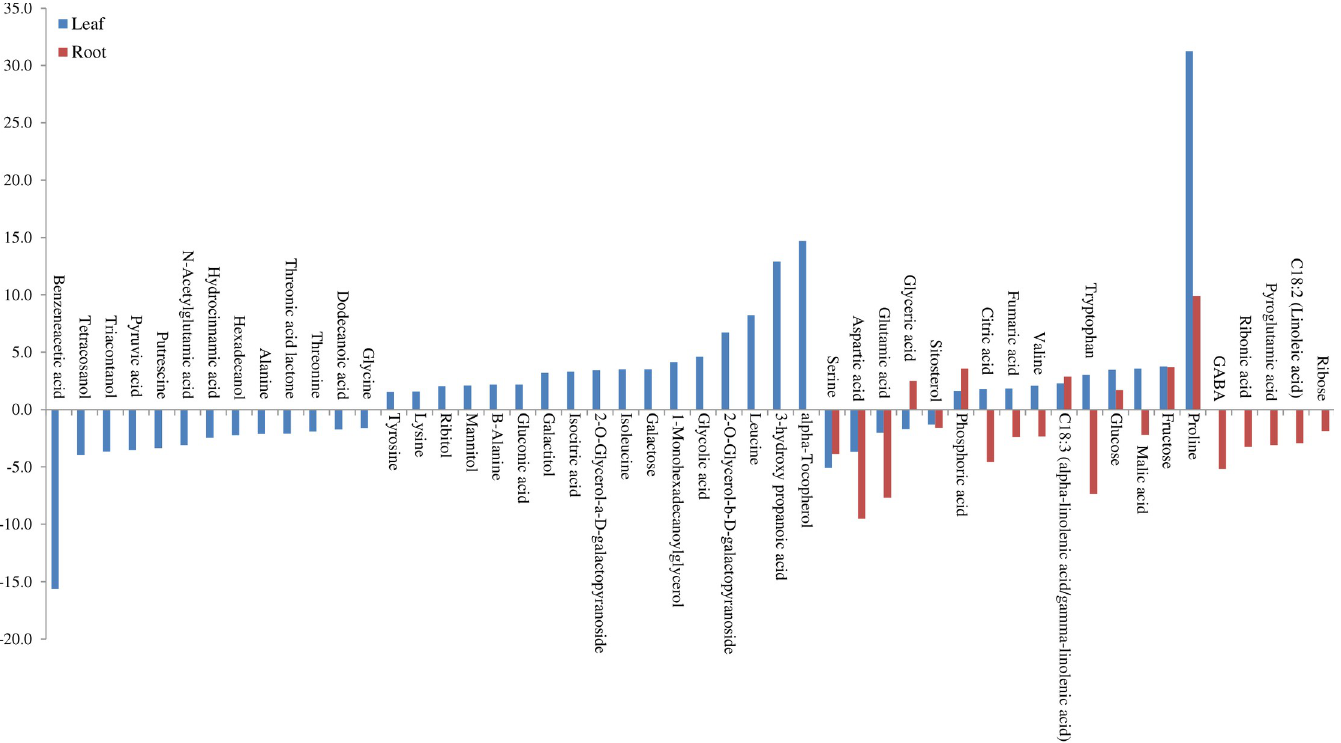
Fig 6. Metabolites of the absolute value of fold change (Drought/Control) which were more than 1.5 in leaf and root separately, and common in both in LA754.